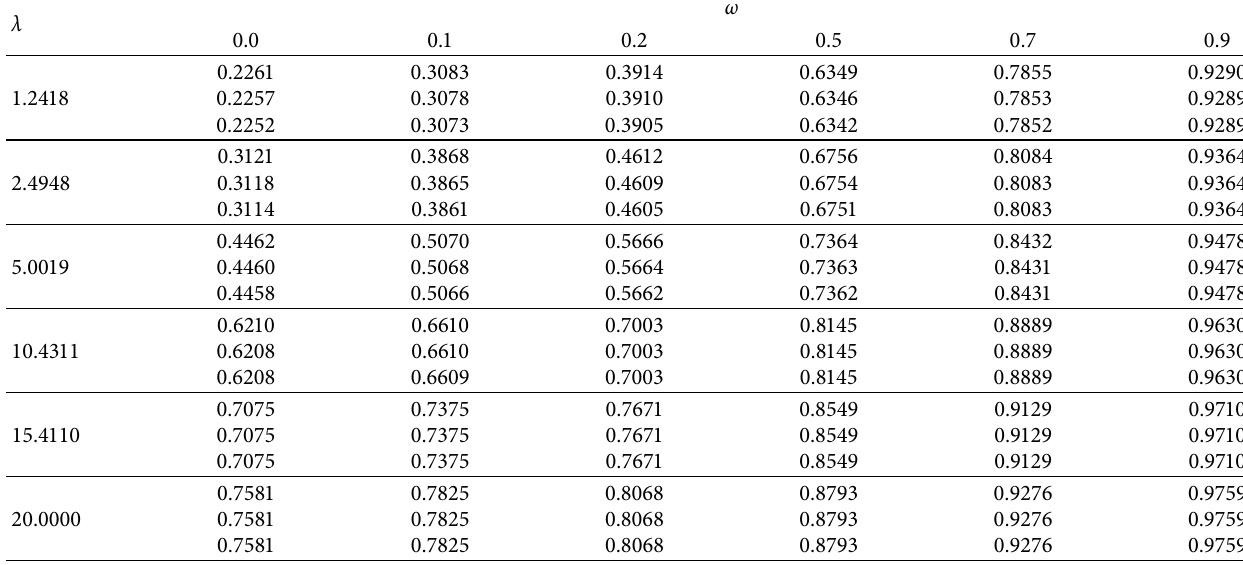
Table 2: Values of risk ratios R for d � 10 and diferent values of ω and λ � ‖ ] ‖ 2 .